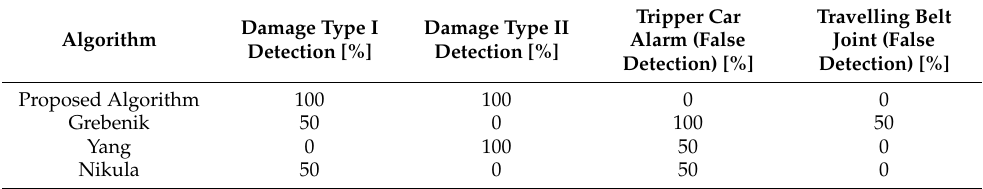
Figure 10. General concept of overheating rollers detection method. Table 1. Results of the algorithm compared with other